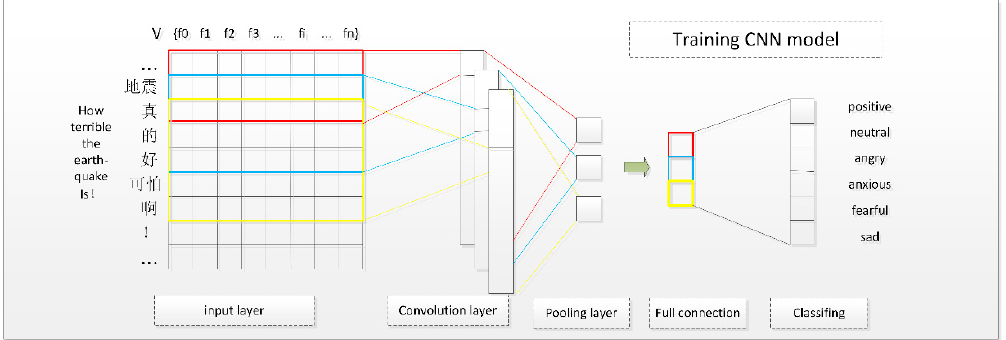
Figure 4. Structure of the convolutional neural network (CNN) model used in the paper.